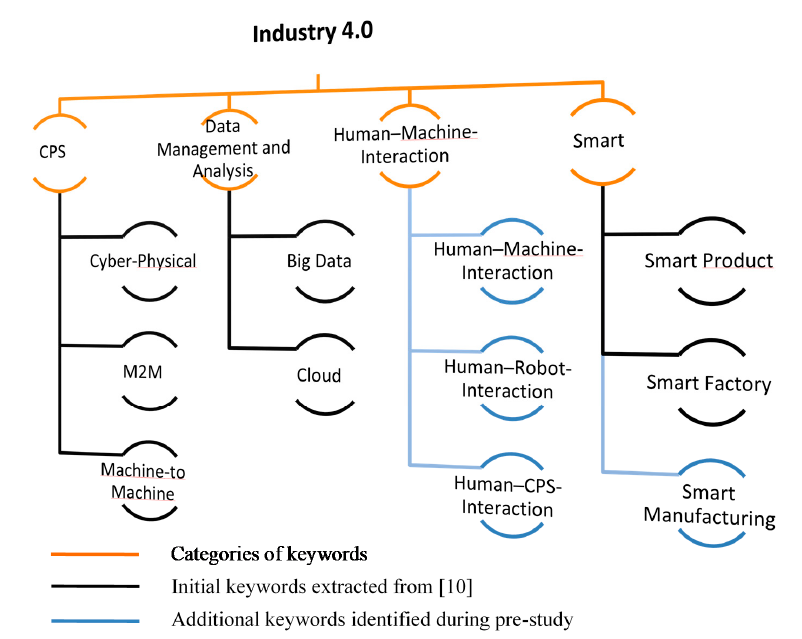
Figure 2. Categories and keywords used in the quantitative analysis. The following abbreviations are used: cyber–physical systems (CPS) and machine-to-machine